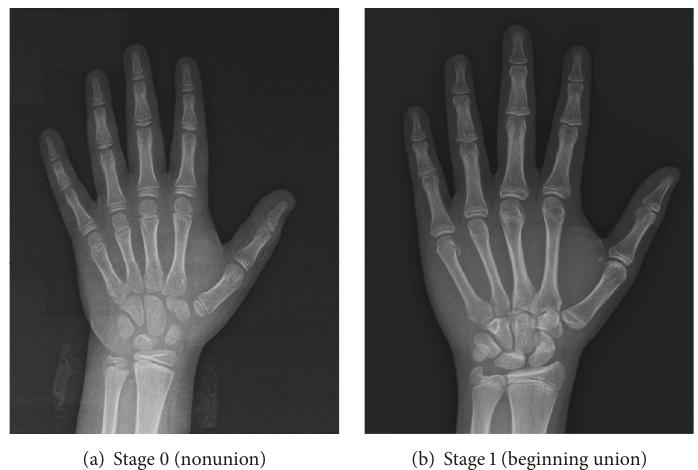
Figure 3: Radiographic images of hand joints showing stage 0 labeled as (a) and stage 1 labeled as